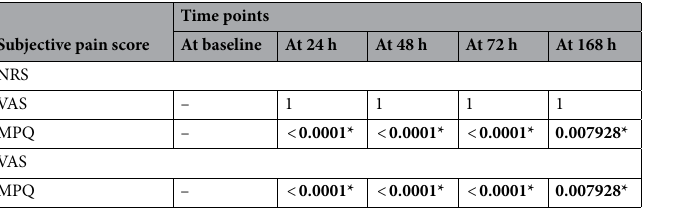
Table 5. p -values of Comparison between subjective pain score – VAS, NRS and MPQ over time points. Significant values are in [bold]. * p < 0.05.